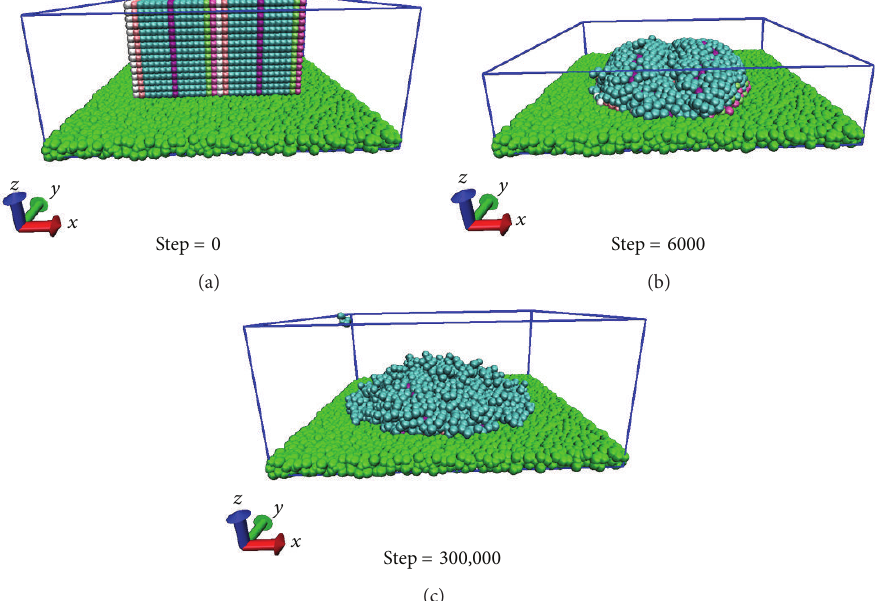
Figure 15: Snapshots of ARJ-DD on DLC surface at different time steps: (a) step = 0; (b) step = 6000; (c) step = 300,000 at temperature 𝑇 ∗ = 4 (668 K = 395 ∘ C) with